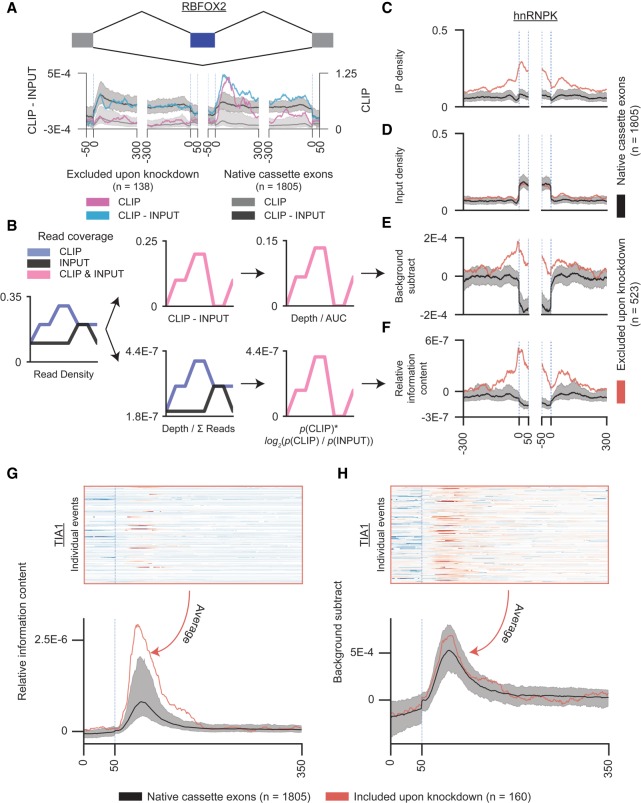
Strategies for normalizing read density maps against an input background. (A) Curves indicate splicing maps generated for cassette exons excluded upon RBFOX2 knockdown using either (pink) eCLIP read density alone or (blue) normalized read density after comparing eCLIP read density versus size-matched input sample. (B) Schematic of the “background subtraction” versus the “information content” normalization for a single example event. (Top) In the “background subtraction” approach, input read density is subtracted from immunoprecipitation (IP) read density, then is normalized against area under the curve represented by read density. (Bottom) In the “information content” approach, read density is normalized to the fraction of total reads in the data set, followed by calculation of a relative information value at each position between IP and input. (C–F) Lines indicate differences observed upon generating splicing maps for excluded events upon HNRNPK knockdown using different inputs and normalization methods: (C) read density in eCLIP only, (D) read density of size-matched input only, (E) “background subtraction” normalization, and (F) “information content” normalization. (G) Heatmap shows (top) information content-normalized values and (bottom) corresponding average across the 5′ splice site region of a meta-cassette exon for TIA1 (HepG2). (H) As in G, but shown for background-subtraction normalized values.